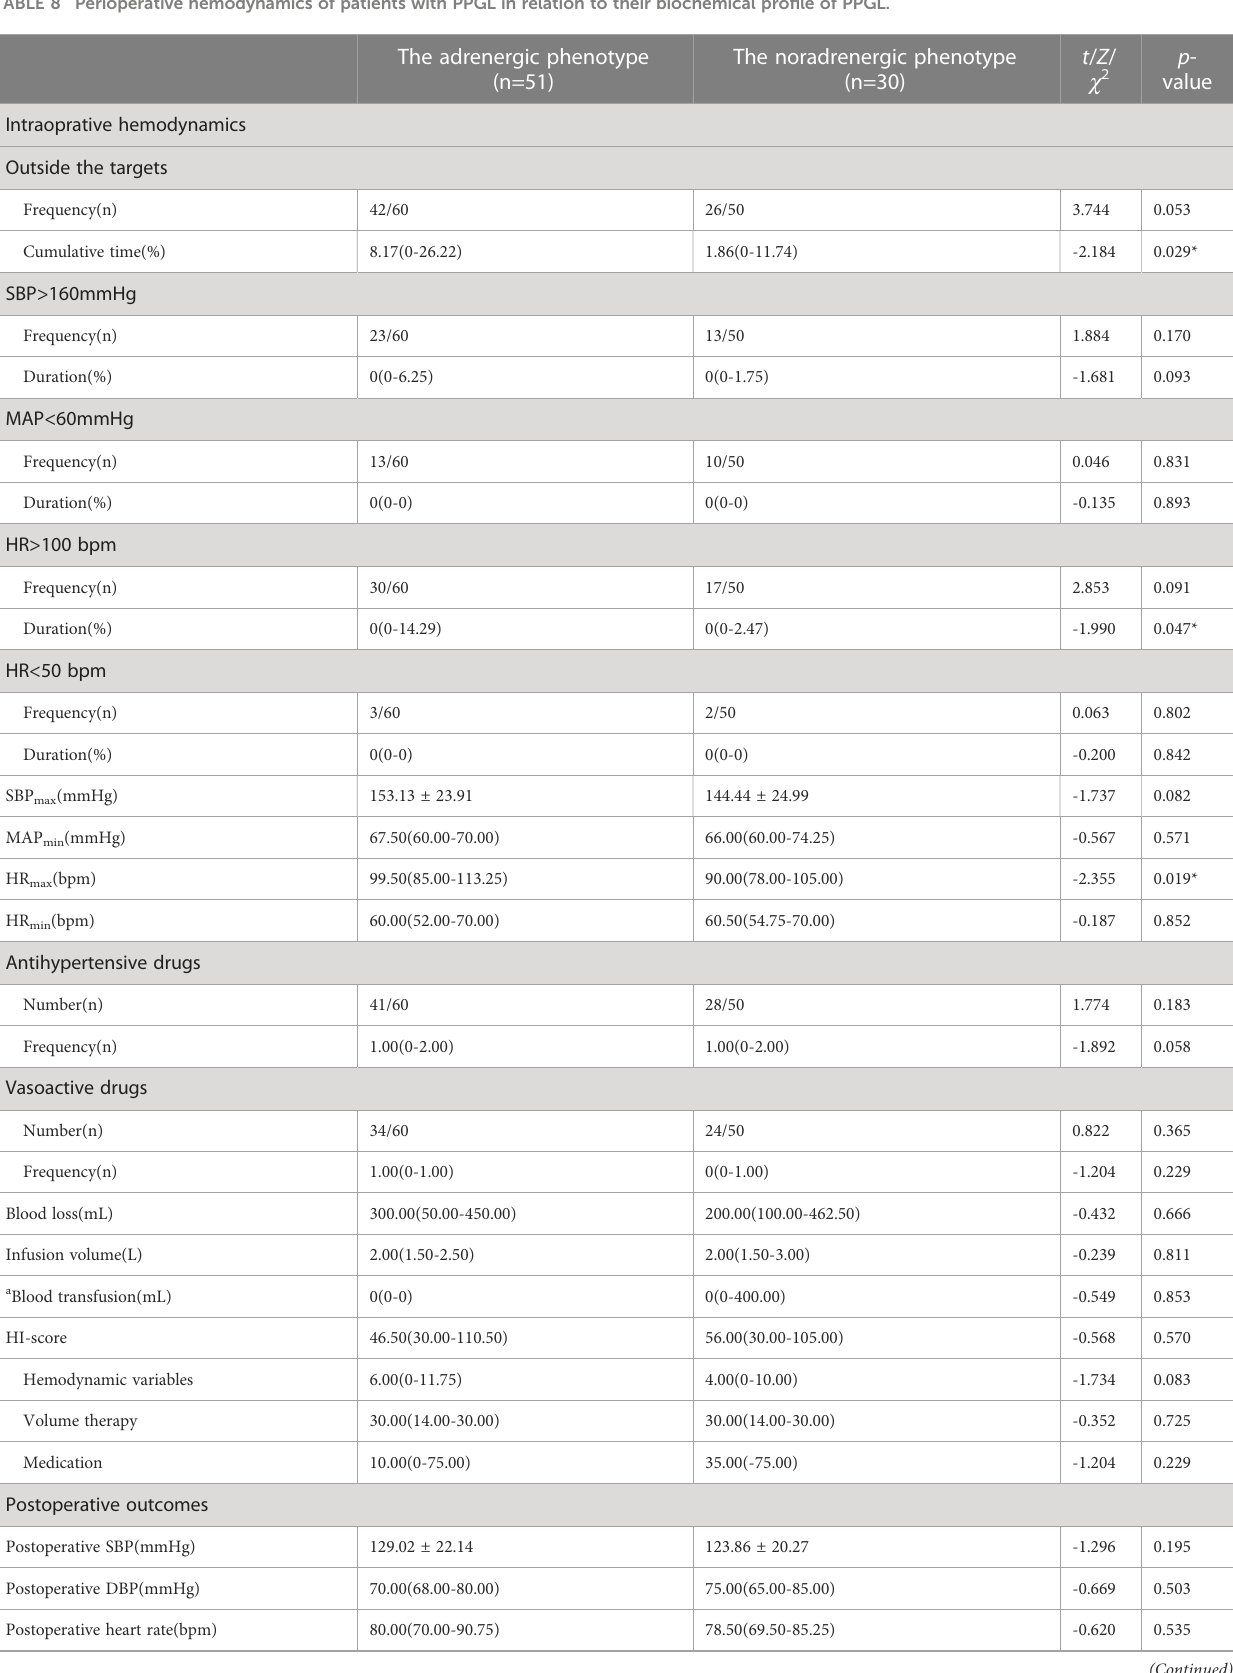
TABLE 8 Perioperative hemodynamics of patients with PPGL in relation to their biochemical pro fi le of PPGL.